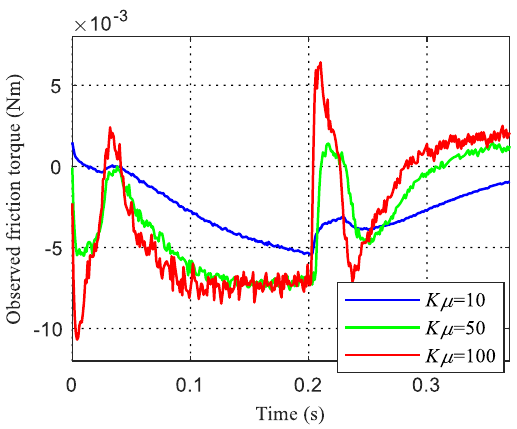
Figure 10. Observed total friction torque mapped to the motor side at high velocities.